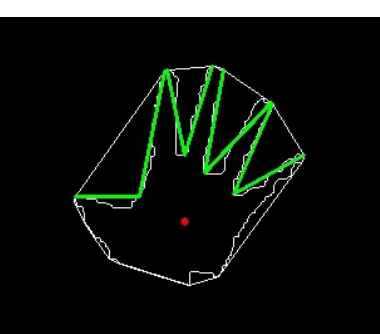
Figure 6. Convexity